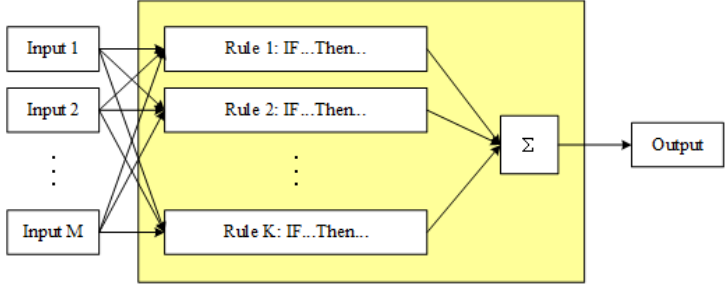
Fig. 1. Structure of a conventional FIS.